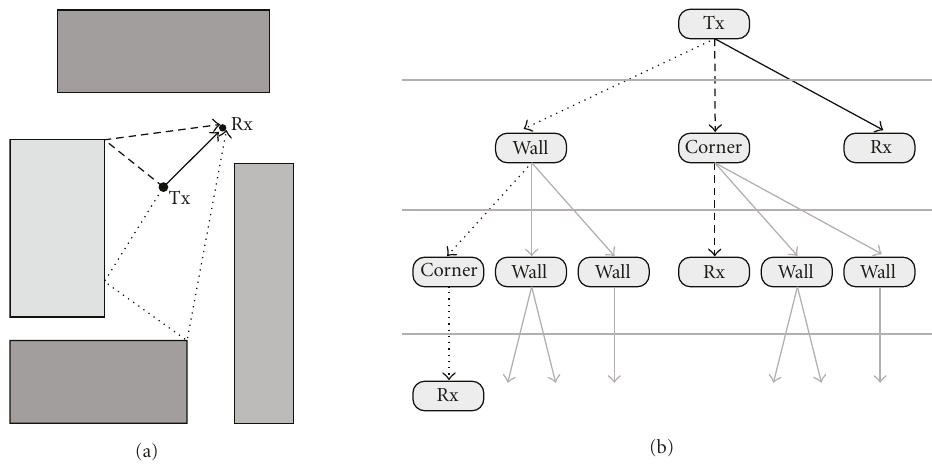
Figure 3: Simple RT illustration: (a) propagation scenario (gray shading indicates buildings); (b) corresponding visibility tree (first three layers